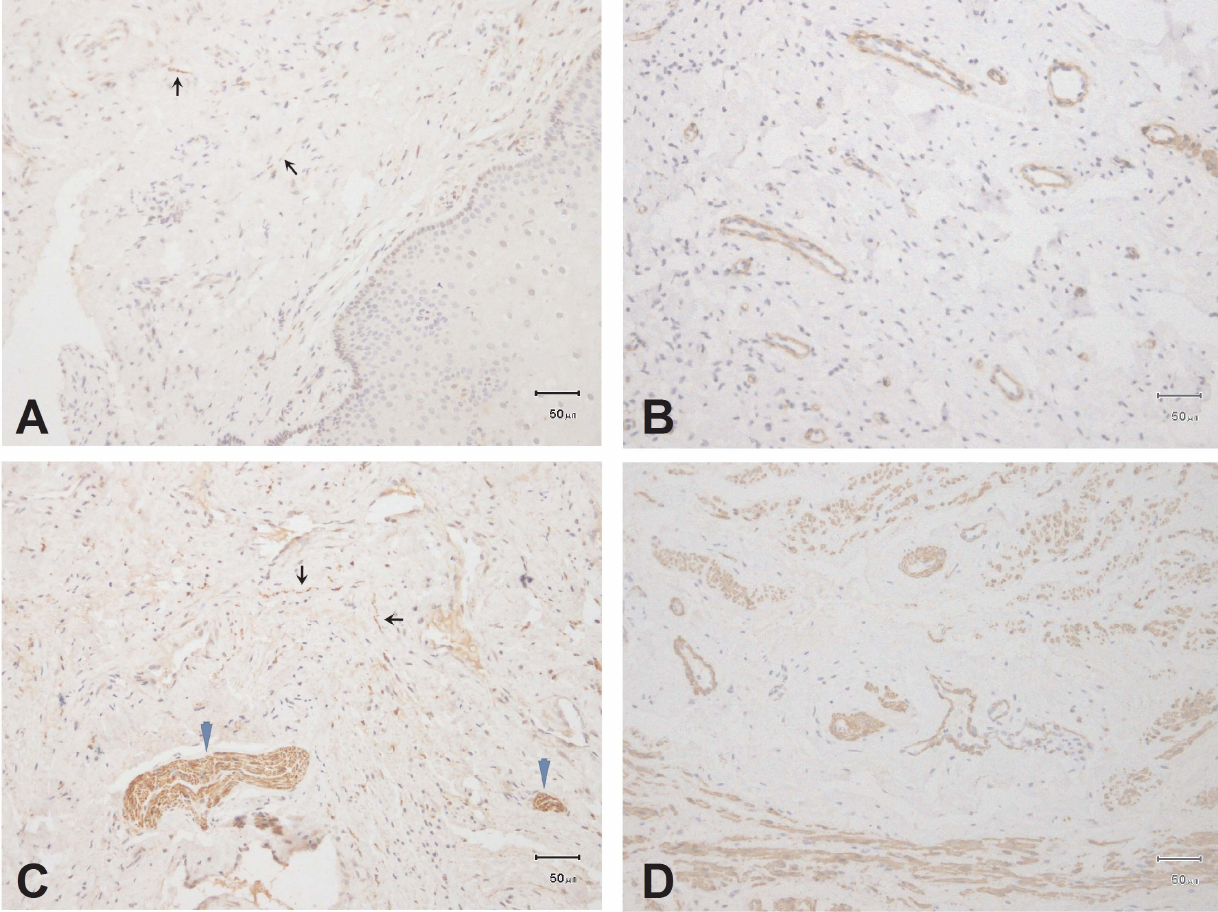
Figure 1. PGP9.5 immunostaining: Vaginal tissue sections from the lamina propria layer (A) and muscle layer (C), nerve bundles indicated by blue arrowheads, small nerves indicated by small black arrows. w k w lamina propria layer (B) and muscle layer (D). Scale bar represents 100 mm